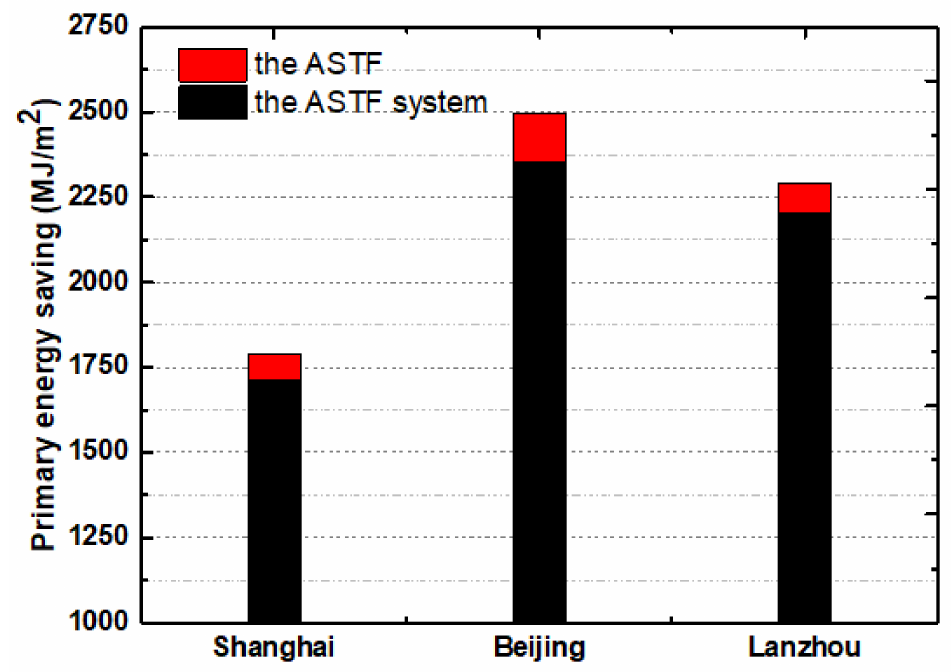
Figure 10. Primary energy savings in three cities.